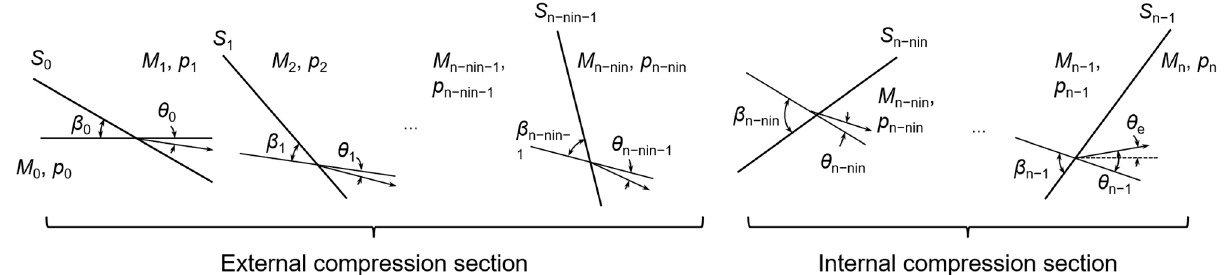
Figure 1. Schematic of a two-dimensional scramjet inlet. ( a ) schematic of geometric parameters; ( b ) close-up of the cowl.